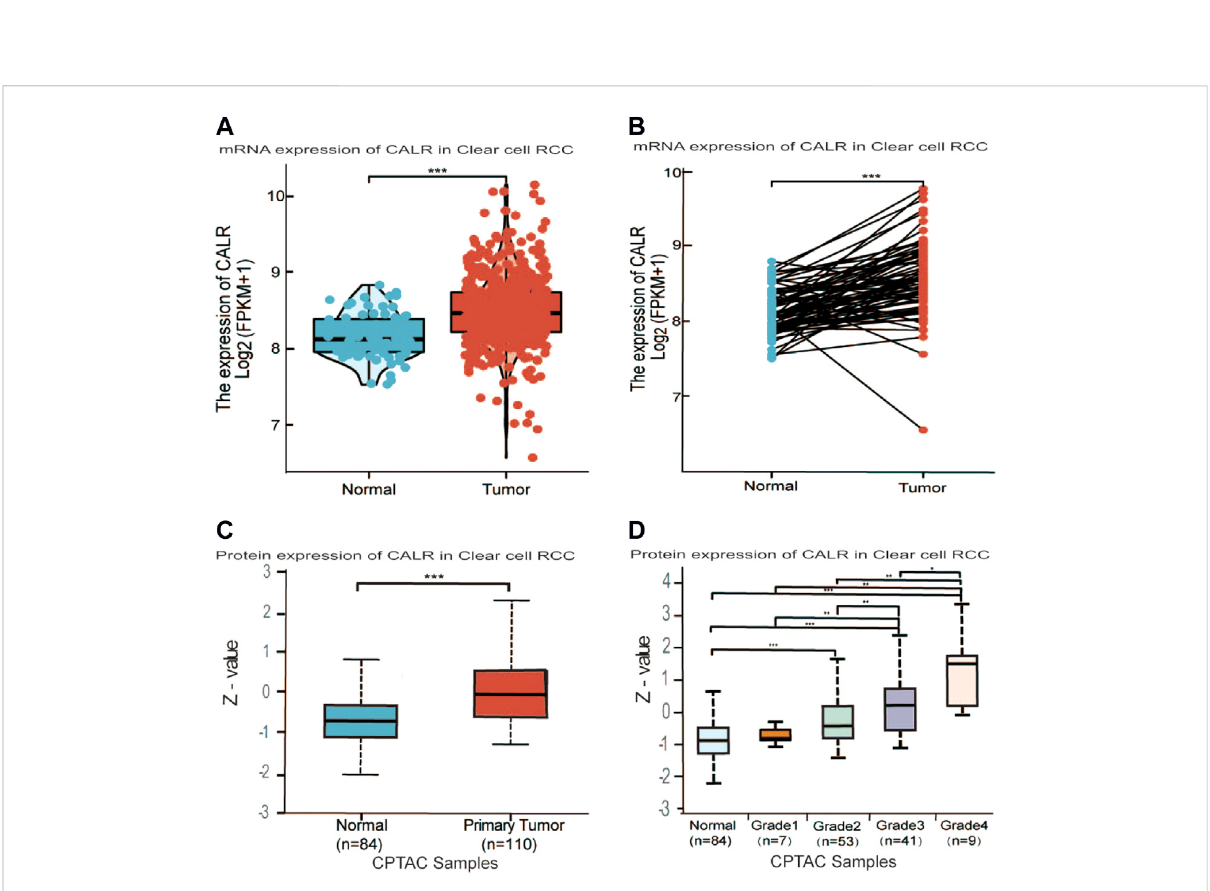
FIGURE 2 Differential expression analysis of CALR in KIRC. (A,B) CALR mRNA expression in normal and tumor tissues. (C,D) Protein level expression of CALR in